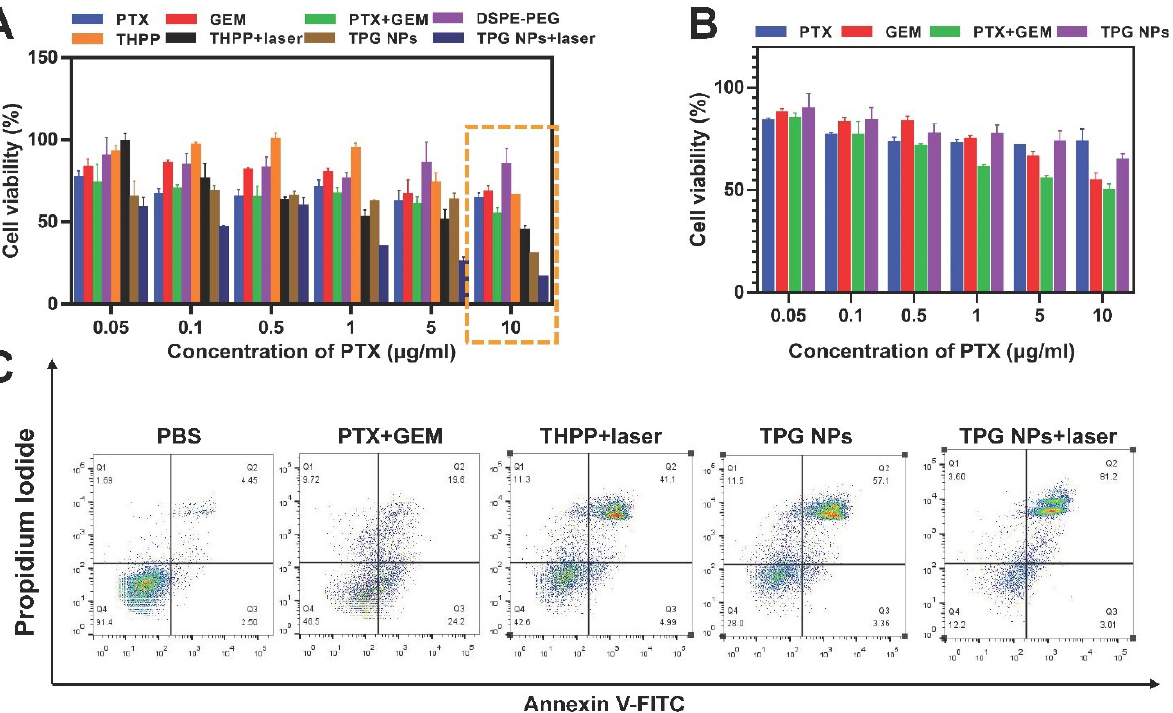
Figure 3. TPG NPs in vitro cytotoxicity assays. The cell viability of PANC-1 ( A ) and MCF-10A ( B ) cells tested by WST 1 assays. Cells were treated with different formulations for 48 h. ( C ) Flow cytometry analyzing of PANC-1 cells; cells were treated with different formulations for 48 h and stained with PI and Annexin V.